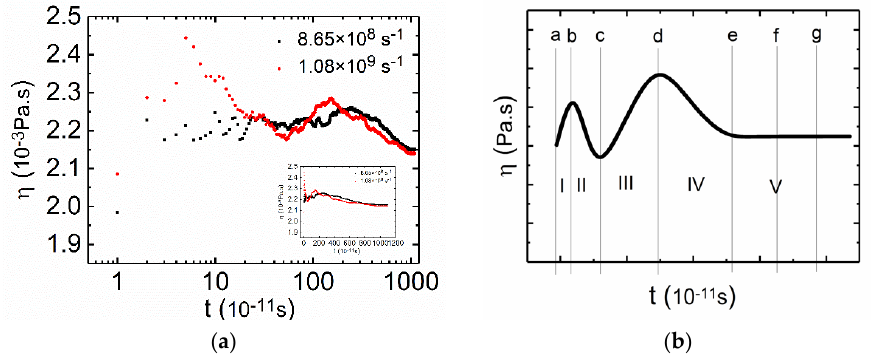
Figure 4. ( a ) Shear viscosity versus time at low rates for the PAM based solutions shown in the logarithmic axis. The small figure is the same curve shown in linear axis. C CTAC = 0.3 mol·L − 1 , C PAM = 2.96 × 10 − 3 mol·L − 1 , counter ion salt is NaSal, R is 0.8, T = 300 K. Black square: shear rate is 8.65 × 10 8 s − 1 . Red circle: shear rate is 1.08 × 10 9 s − 1 . ( b ) Schematic curve of the PAM based solution under low shear rates.